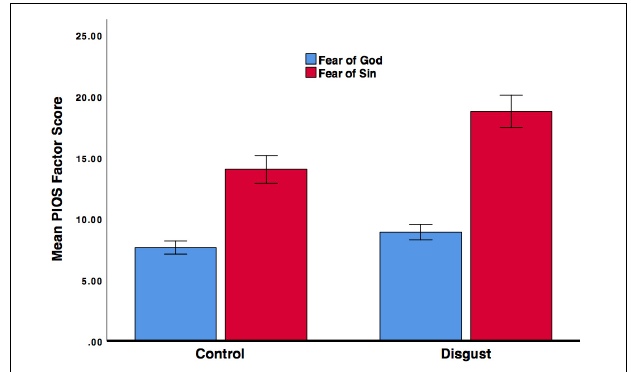
FIGURE 1 | The treatment effects on fear of God and fear of sin scrupulosity domains for the experience of disgust.